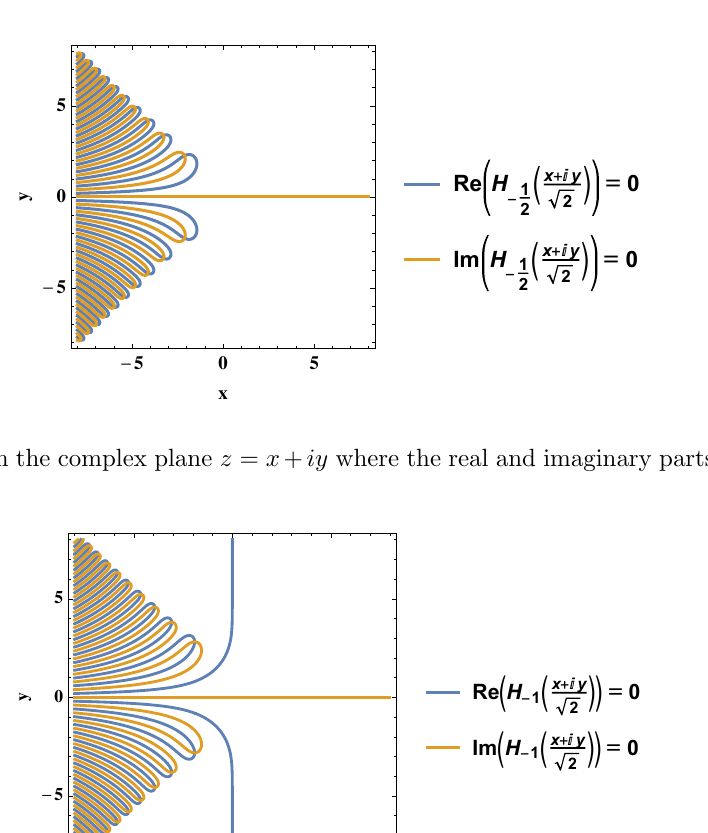
(cid:16) (cid:17) z p 2